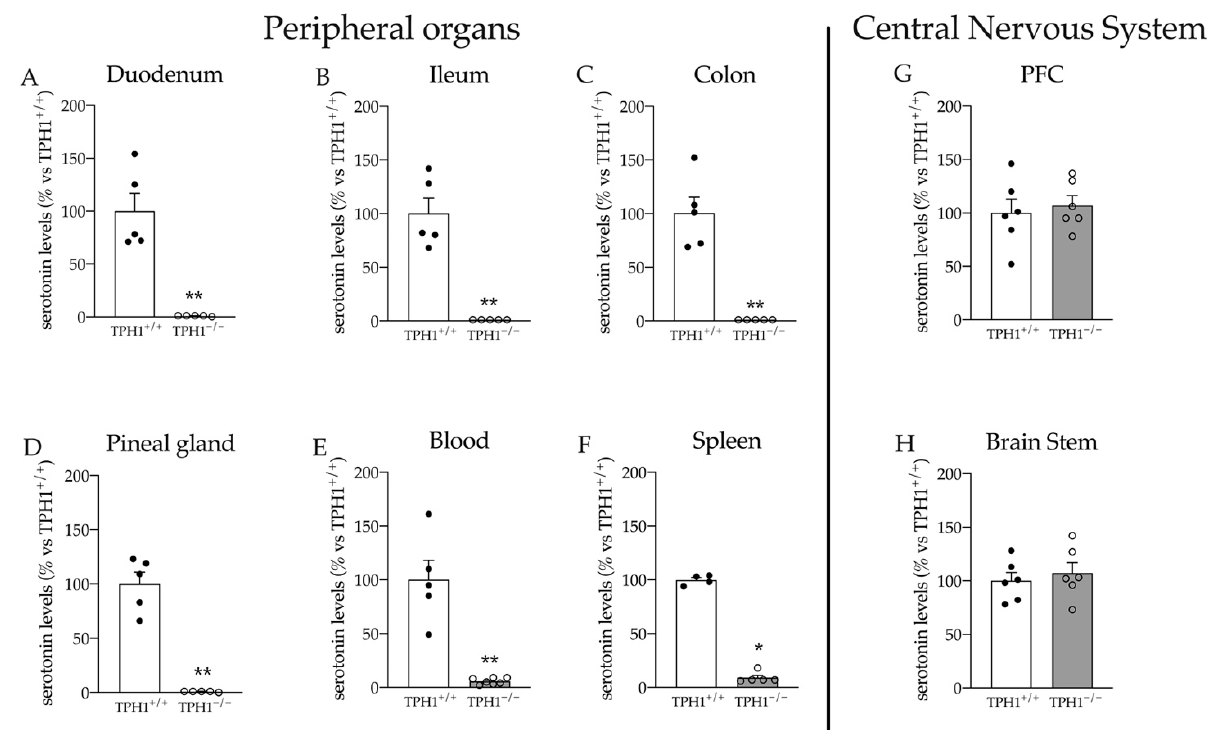
Figure 1. Serotonin levels in the duodenum ( A ), ileum ( B ), colon ( C ), pineal gland ( D ), blood ( E ), spleen ( F ), PFC ( G ) and in the brain stem ( H ) of TPH1 +/+ and TPH1 − / − rats. Data are presented as means ± standard error (SEM) of at least 4 independent determinations. * p < 0.05 ** p < 0.01 vs. TPH1 +/+ ; Student’s t -test.